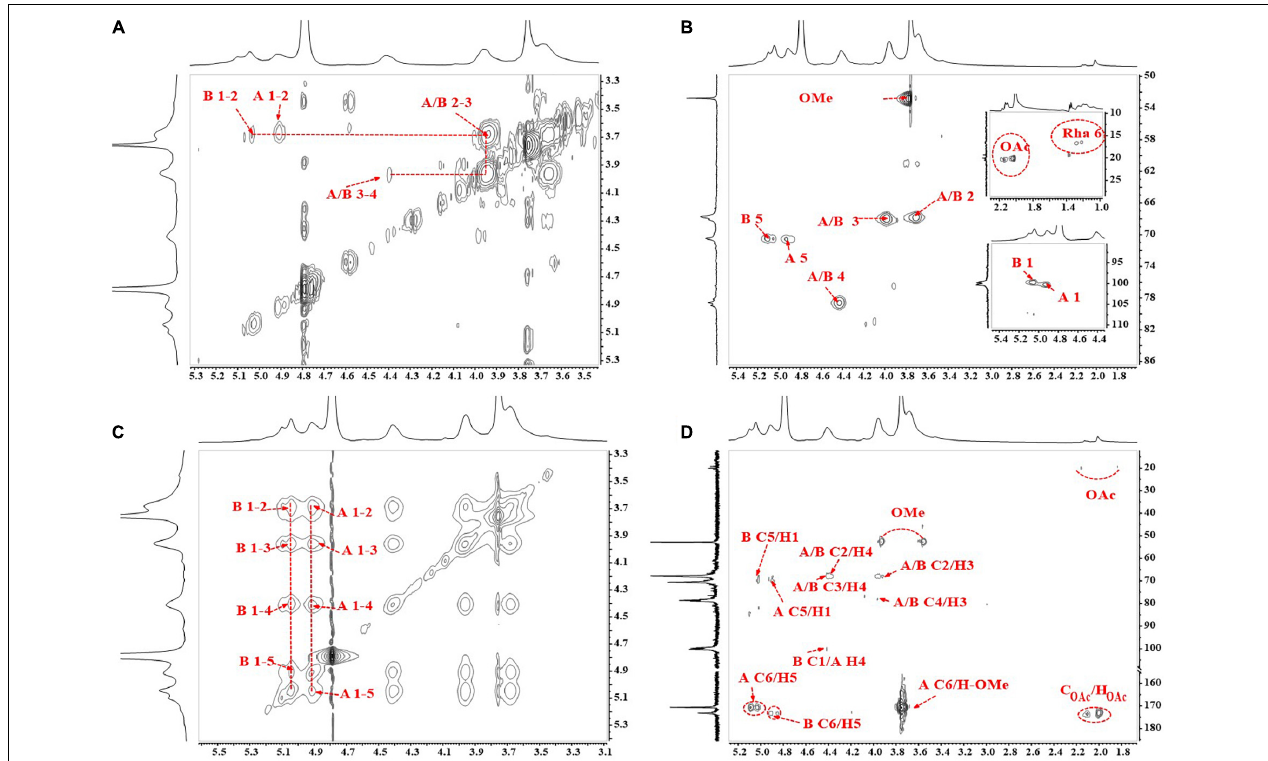
FIGURE 5 | 2D nuclear magnetic resonance (NMR) spectra of GPS2b. (A) 1 H- 1 H correlation spectroscopy (COSY) spectrum; (B) HSQC spectrum; (C) 1 H- 1 H nuclear overhauser effect spectroscopy (NOESY) spectrum; (D) 1 H- 13 C heteronuclear multiple-bond spectroscopy (HMBC)